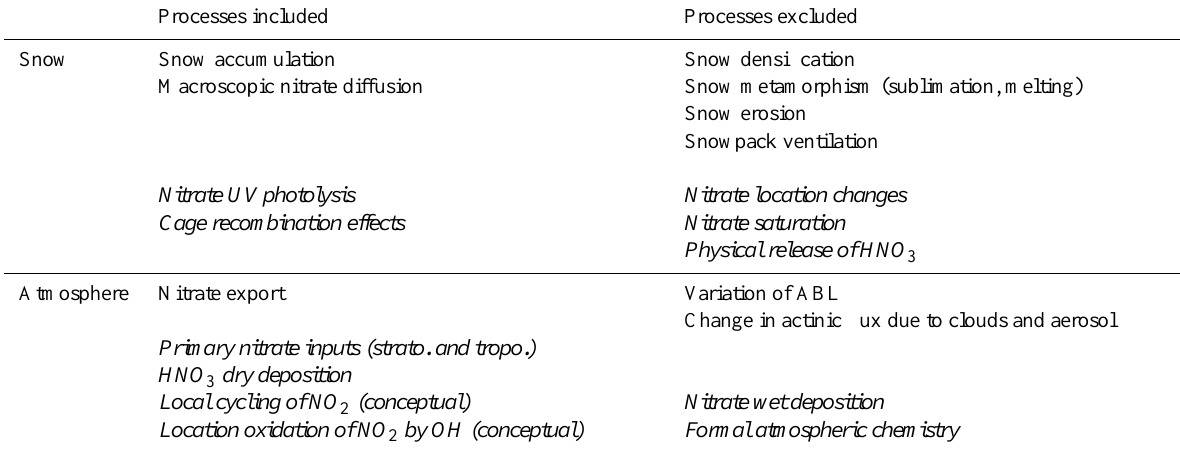
Table 2. List of the physical and chemical processes included and excluded in TRANSITS. Physical and chemical processes are written in roman and italic font,